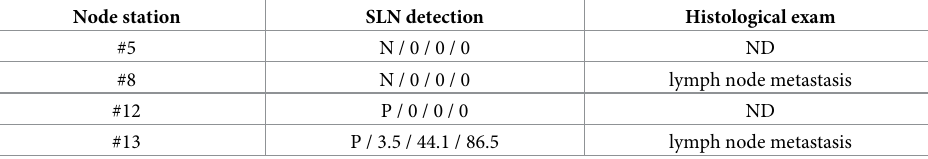
Data for SLN detection are in the following sequence: Indocyanine green hotspot (P, Positive; N, Negative)/magnetic field during laparoscopic surgery ( μ T)/magnetic field of the extracted lymph nodes ( μ T)/iron content ( μ g). SLN = Sentinel lymph node, ND = Not